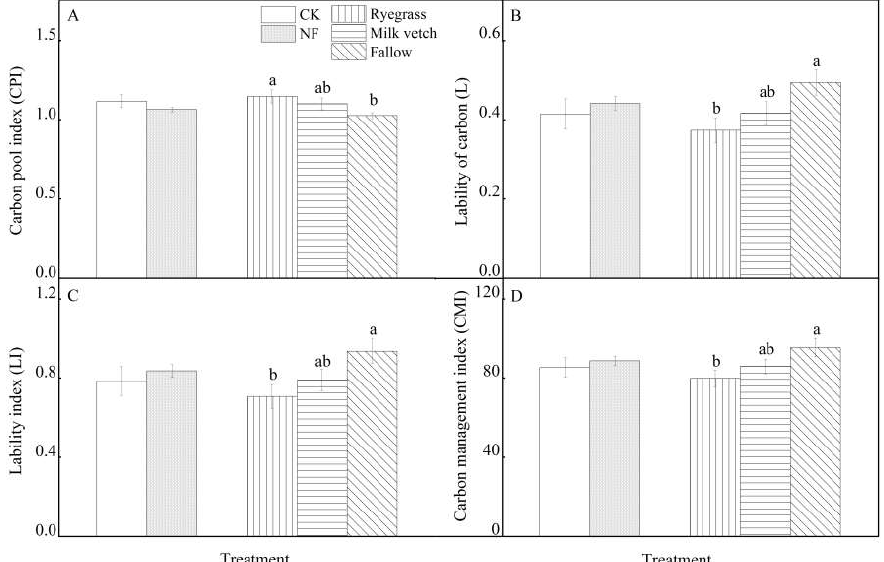
Figure 2. Soil carbon management indices (( A ), CPI; ( B ), L; ( C ), LI; ( D ), CMI) (means ± se) under fertilization and green manure amendment. Results were averaged across fertilization and green manure amendment treatment because there were no significant 2-way interactions. Different letter on the bars means the significant difference with confidence level set at 0.05.